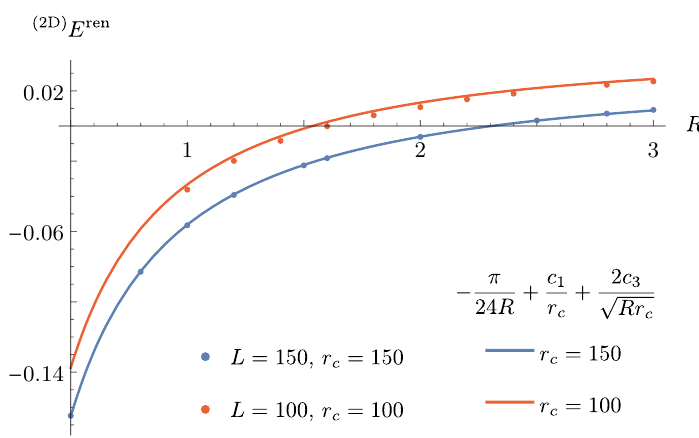
+ c 1 + 2 c 3 √ , with free 24 R r c Rr c